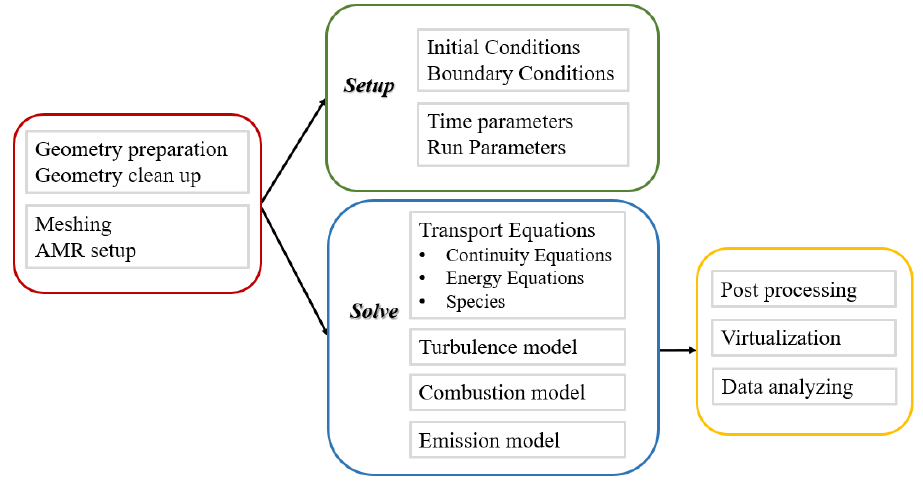
Figure 4. Flow chart of the simulation process.